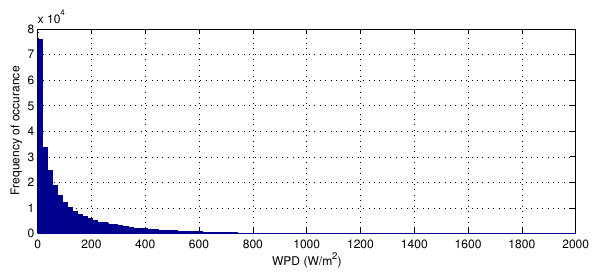
Fig. B1. Illustrative distribution of the WPD. The histogram corre- sponds to an example grid point in the central